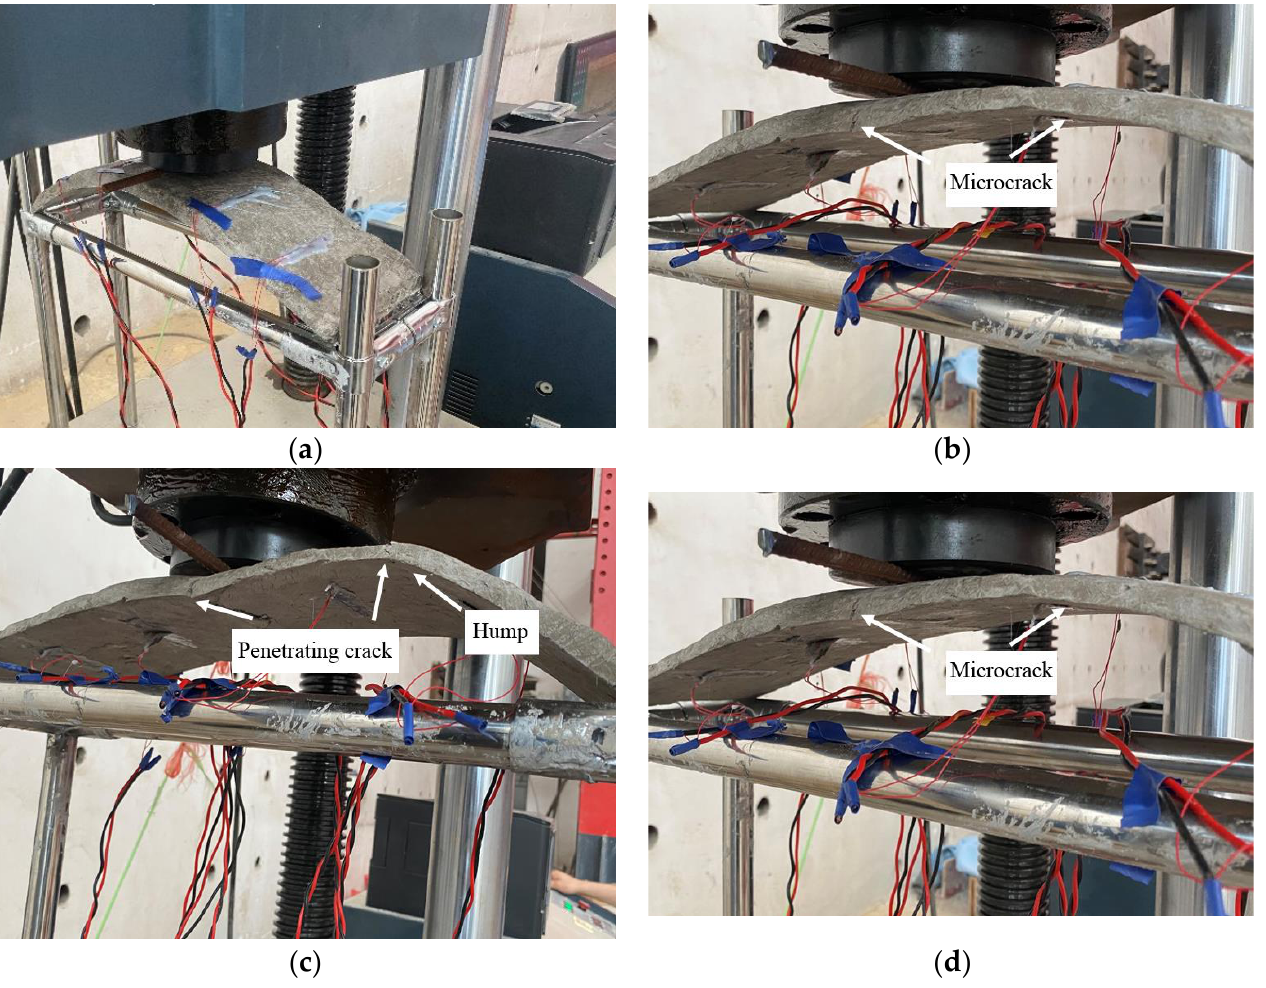
Figure 11. Failure pattern of the traditional concrete thin-shell structure: ( a ) Initial loading stage; ( b ) Cracking stage; ( c ) Penetrating stage; ( d ) Failure stage.